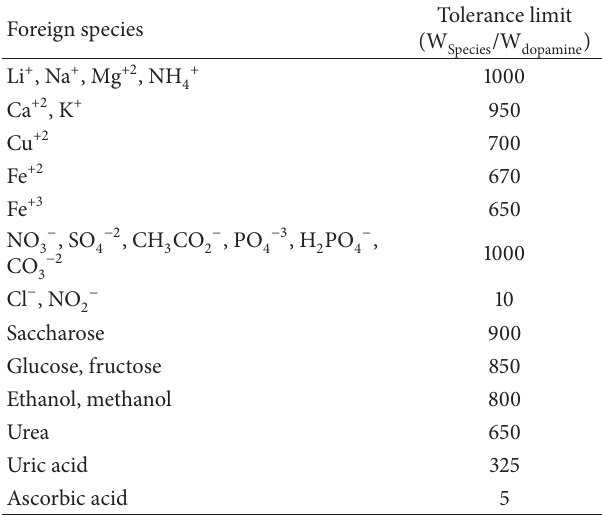
Table 2: Interfering effect of foreign species on the determination of 1.0 𝜇 gmL − 1 of